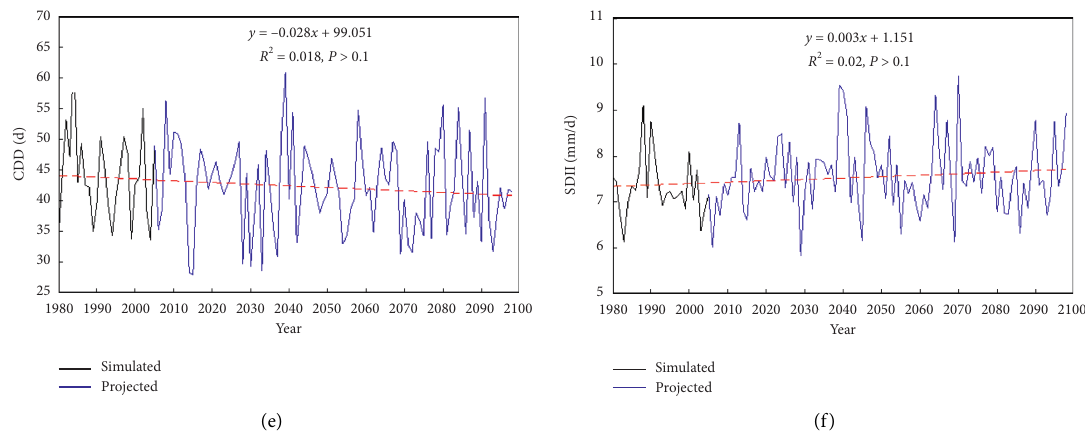
Figure 7: Temporal evolution of the EPIs from 1980 to 2098 in Shaanxi Province as simulated and projected by the RegCM4: (a) Rx1day; (b) Rx5day; (c) R95p; (d) R10 mm; (e) CDD; (f) SDII. The dashed line represents a linear trend.